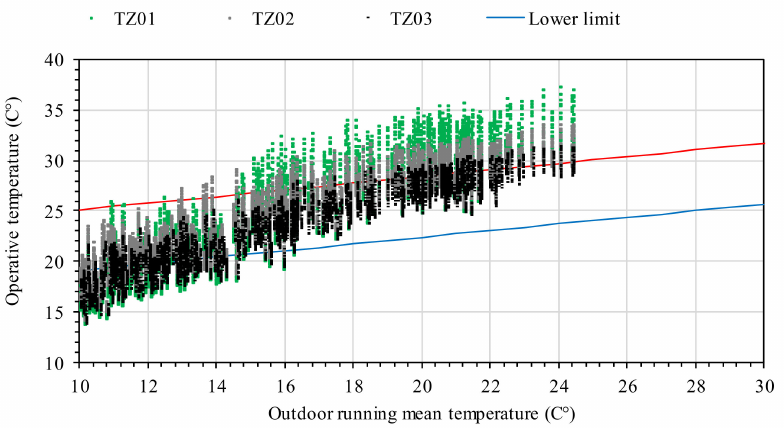
Figure 14. Thermal comfort analysis using EN16798-1 for the enhanced solution with BioPCM ® M 91 /Q 25 _0.037.